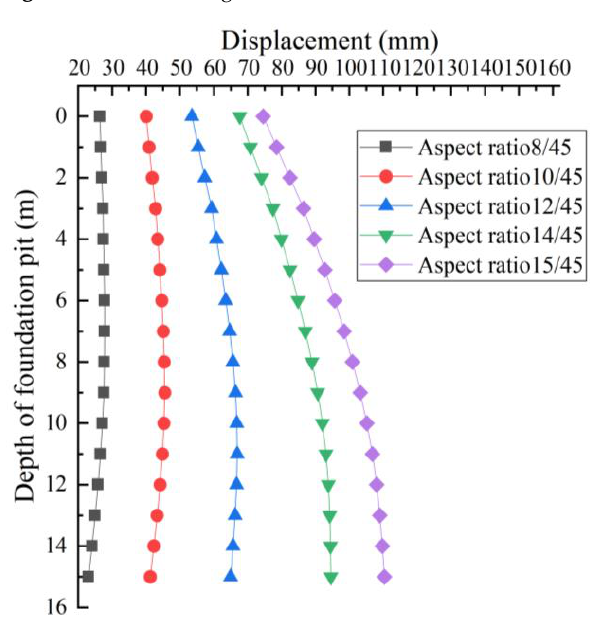
Figure 19. Pile displacement behavior.